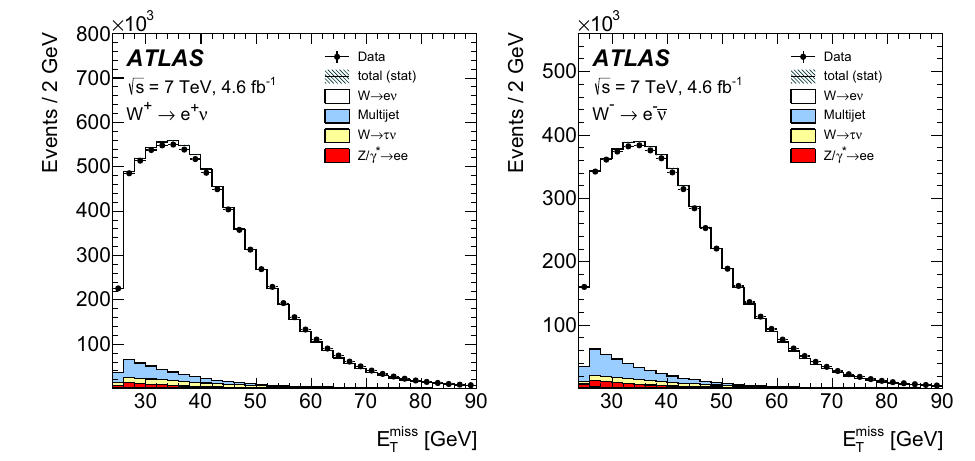
Fig. 5 Themissingtransversemomentumdistributionfor W + → e + ν candidates ( left ) and W − → e − ¯ ν candidates ( right ). The simulated samples are normalized to the data luminosity. The multijet background shape is taken from a data control sample and normalized to the esti-